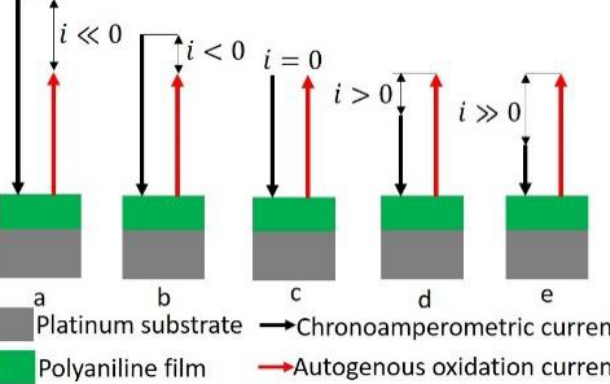
Scheme 1. Schematic representation of the turning potential method for determination of autogenous oxidation